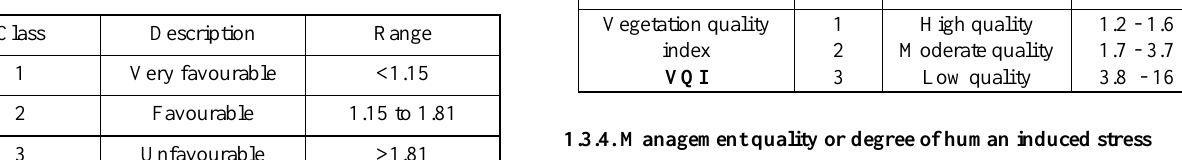
Table 4. Climate quality index